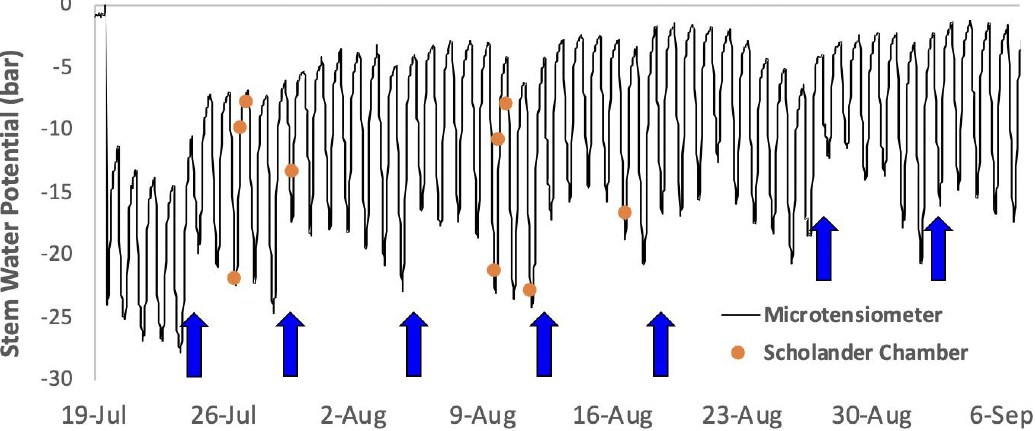
Figure 7. Daily cycles of almond stem water potential determined by the microtensiometer and SPC (dots) with irrigations noted by blue arrows. Reproduced from Lakso et al., 2022 [47]. Note that the stem potential units are bars. One bar = 0.1 MPa.